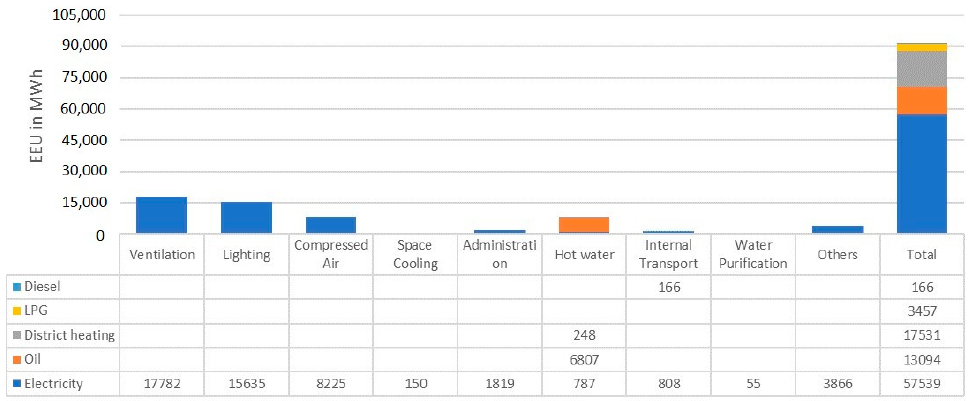
Figure A4. Energy use for the unit processes in the support category based on the case study of the Swedish engineering industry.